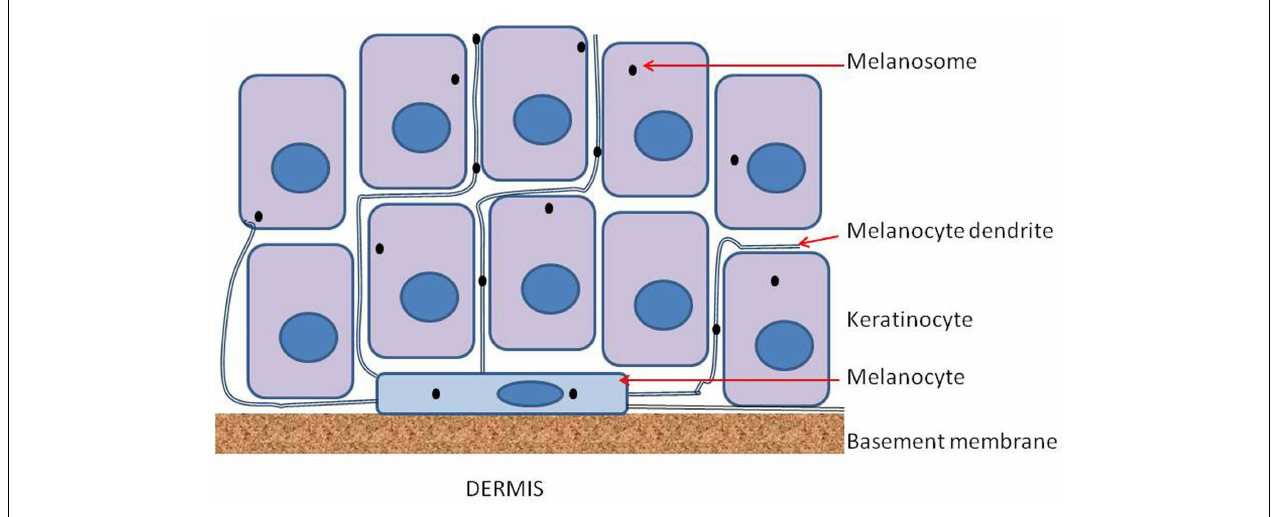
melanosomes from each melanocyte to a number of keratinocytes. Connections between adjacent melanocytes also involve dendrites but are not shown in the